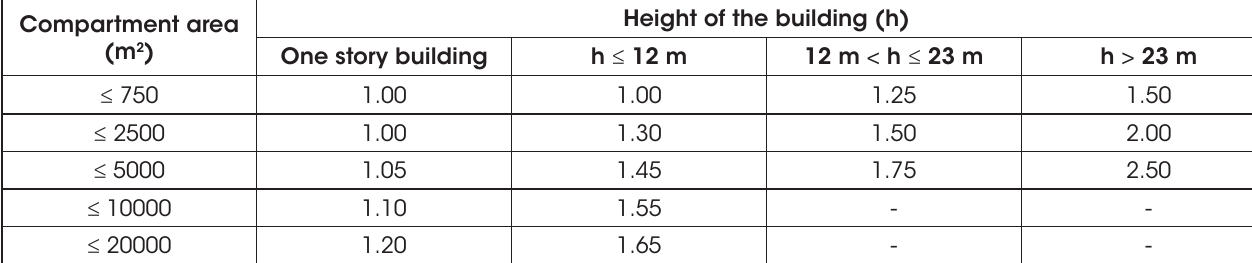
Values of γ (IT 8, 2001) s1 Compartment area